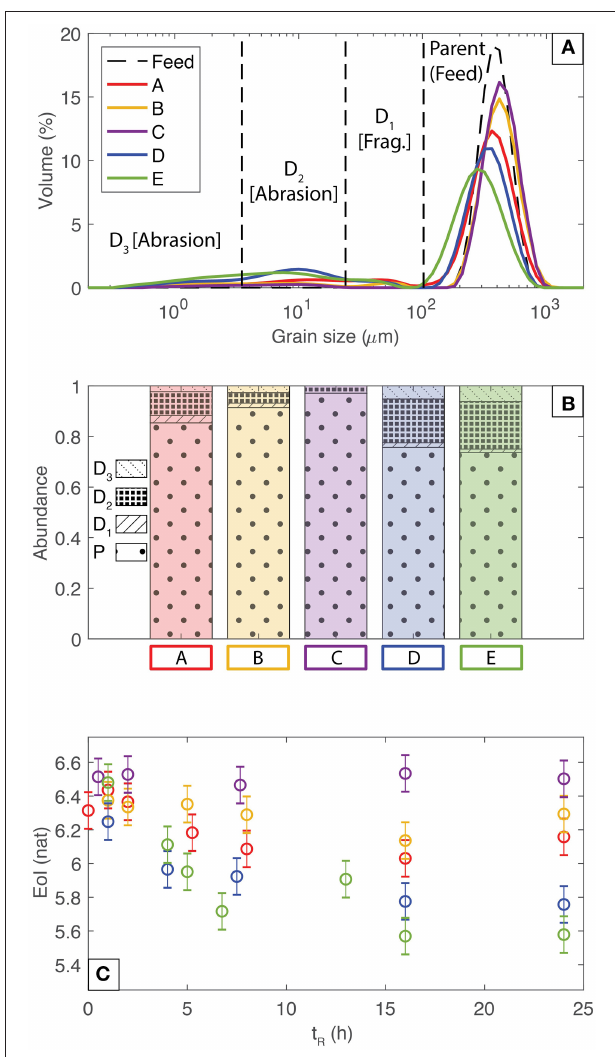
FIGURE 7 | (A) Total grain size distributions for the longest duration (24h) experiment from each series (A through E; see Table 1 ). Subpopulations of grains (parent, daughter 1, daughter 2, and daughter 3) are denoted by the vertical dashed lines. Corresponding curve fitting data can be found in Table S3 . (B) The proportions of parent (P) and different daughter particles (D 1 , D 2 , and D 3 ) for the experimental series A–E after 24h. (C) Calculated values of the weighted or combined entropy of information (EoI) for the total grain size distribution for each experimental series ( Table S3 ). Colors in all parts of this figure are consistent with the legend in part (A)